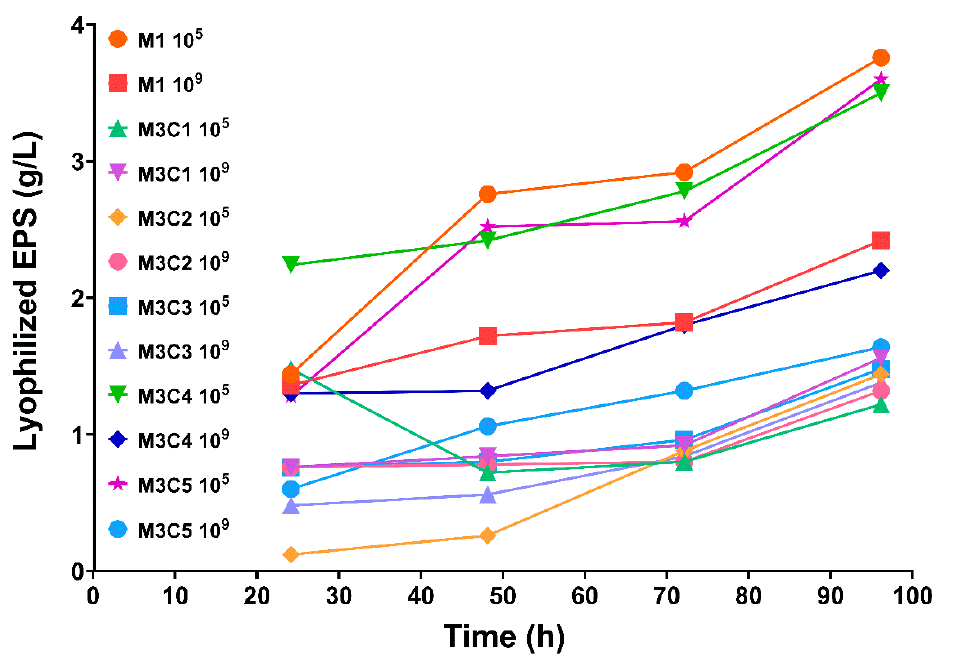
Figure 2. EPS quantification during fermentative processes. Experiments’ codifications are presented in Table 1.